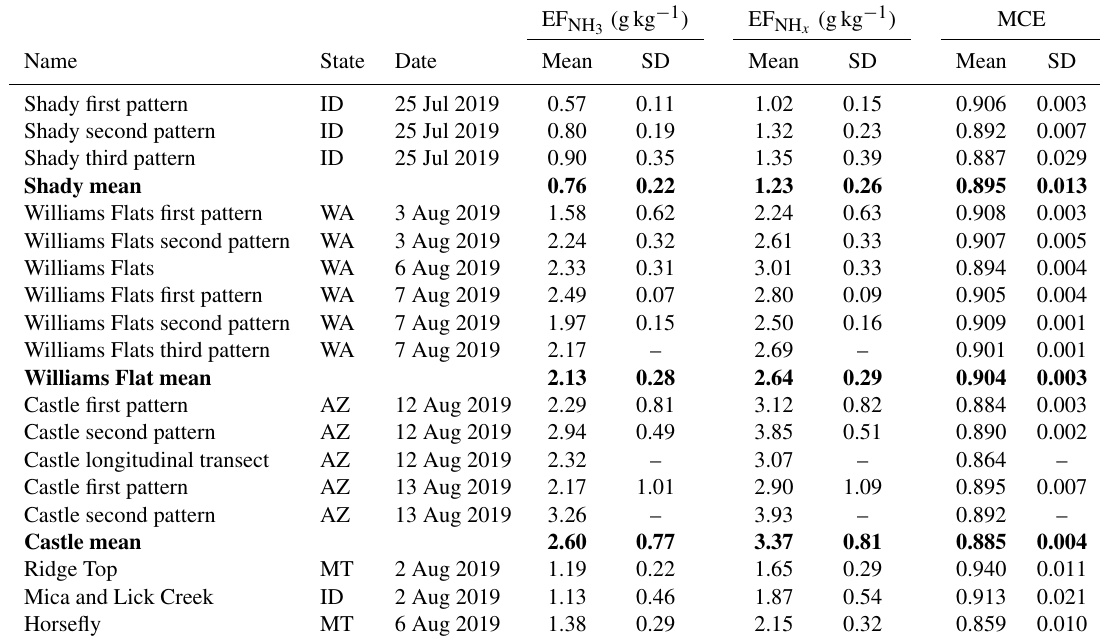
and EF NH derived from in situ measurements in the plumes of six wildfires in the Western United States. The lines in bold Table 1. EF NH x 3 are average values of the above-listed data for the respective